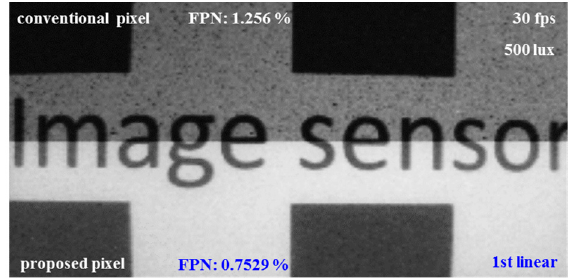
Figure 3. Output image of the image